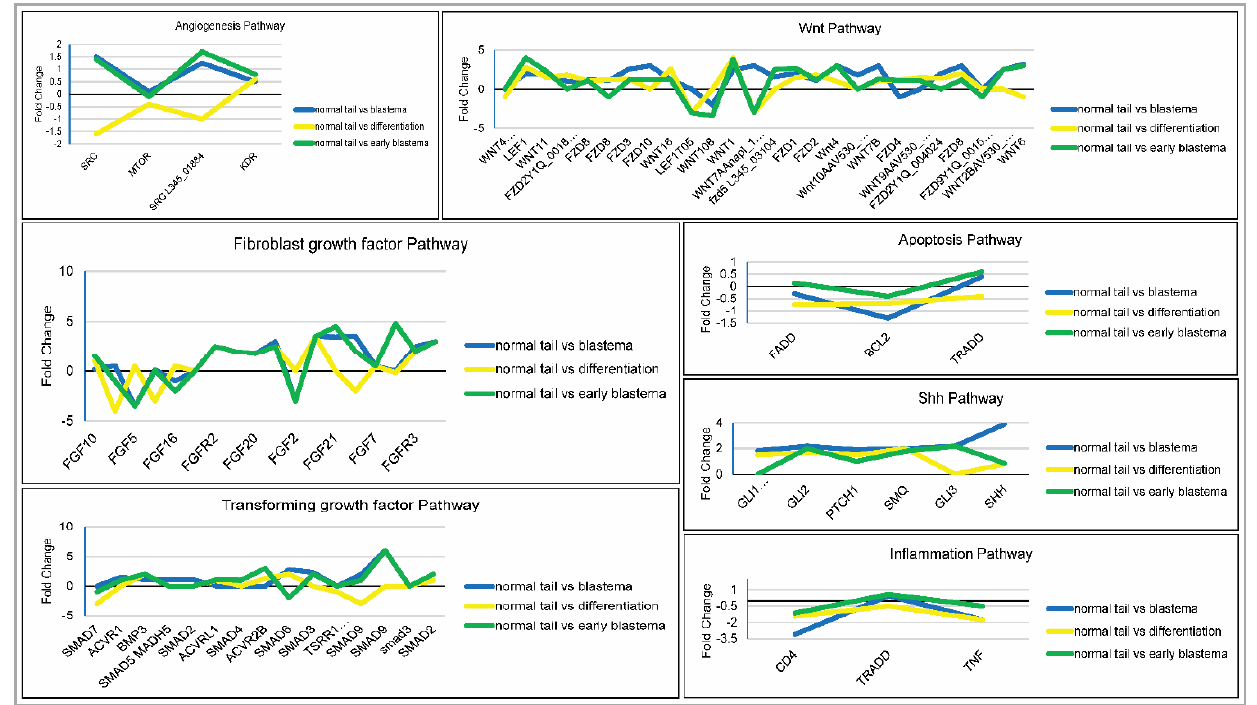
Figure 6. Expression levels of transcripts from developmentally significant signaling pathways in early blastema (EBL), blastema (BL) and differentiation (DF) stages with respect to the normal tail during regeneration in H. flaviviridis. The line through zero represents the respective gene expression levels in normal tail samples considered as a reference. Fold changes in gene expression in other samples (EBL, BL and DF) are compared with this reference.